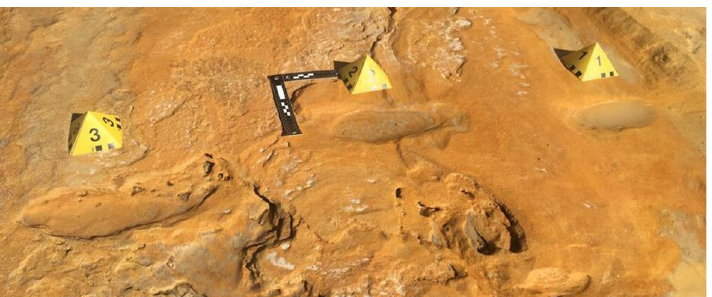
Figure 8. Hominin trackway attributed to a neanderthal adult found in an exposed area of the MTS (see the large well-preserved cervid track in the bottom of the photo). While track 3 still shows several details such as digit impressions and the expulsion rim in its outer part, tracks 2 and 1 were progressively eroded by the tides and lost their morphological features, including the shallower parts of the tracks, becoming